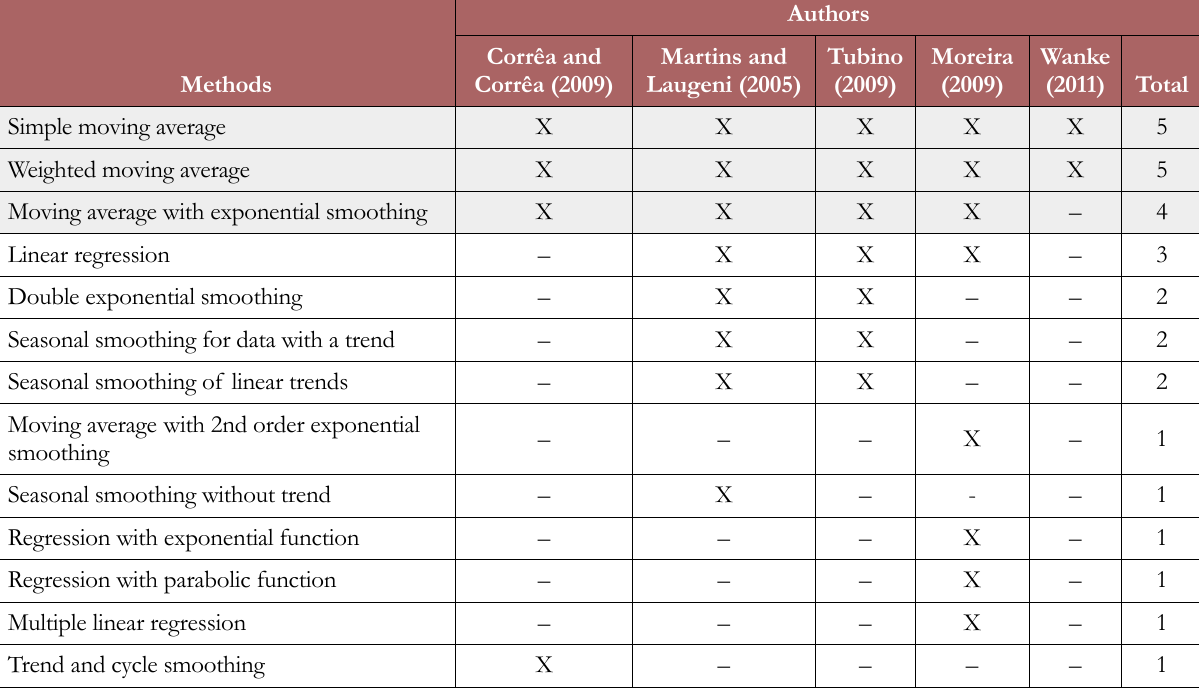
Table 1. Survey of demand forecasting